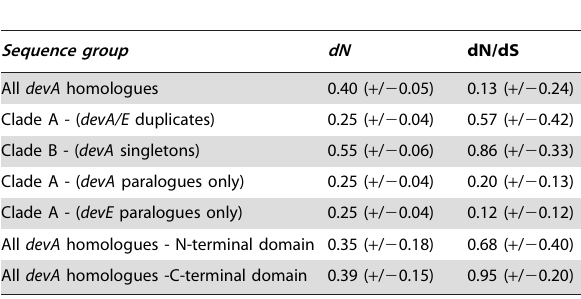
Table 3. Evolutionary analysis of DevA-like